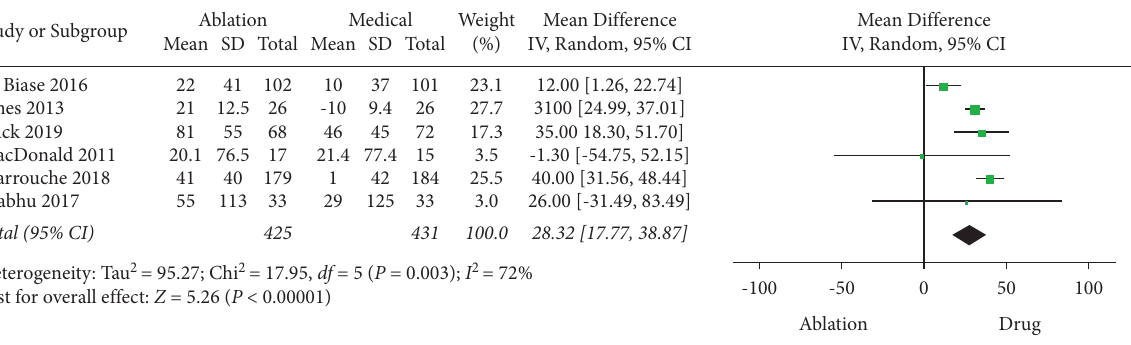
Figure 5: Forest plot of CA versus medical therapy: 6MWT.